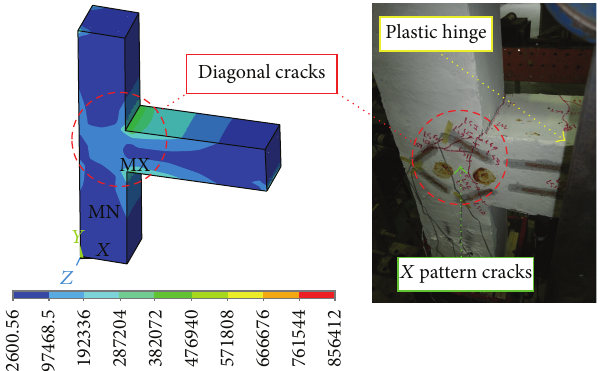
Figure 14: Stress intensity results and the damaged state at the end of seismic test for the DCL-DOUBLE specimen.